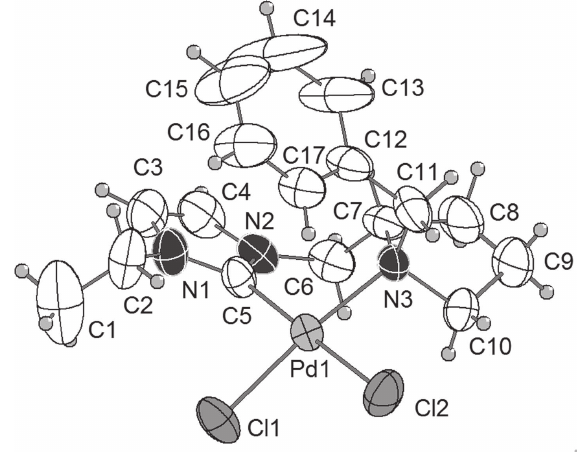
Table 1: Data collection and handling.